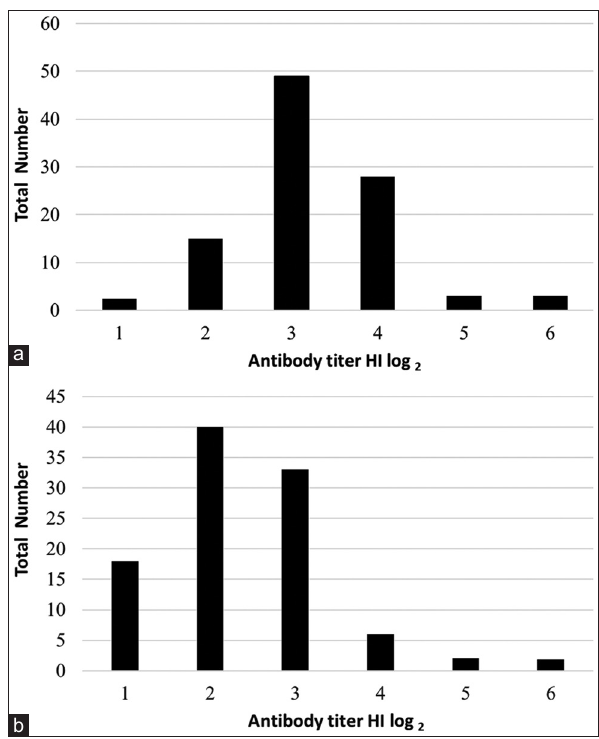
Figure-3: Antibody titers profile at 2 weeks (a) and 3 weeks (b) after vaccination. Group I was vaccinated with inactivated Gianyar-1/AK/2014, Group II was vaccinated with LaSota life vaccine, and Group III was control as injected with phosphate-buffered